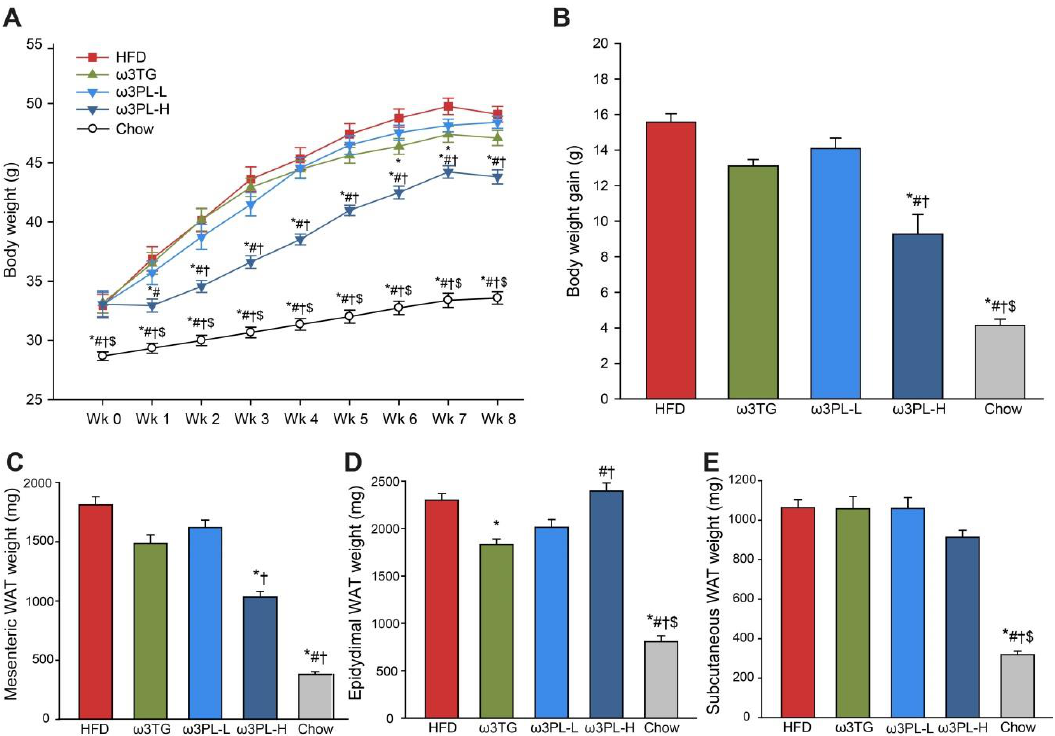
Figure 1. The effect of high-fat diet (HFD) feeding and its supplementation by Omega-3 on body weight ( A ), body weight gain ( B ), mesenteric WAT ( C ), epididymal WAT ( D ) and subcutaneous WAT ( E ) in mice. Tissues were weighed after 8 weeks of dietary intervention, while body weight gain was calculated as difference between Week 7 and 0. Data are means ± SEM ( n = 8). *, significantly different vs. HFD; #, significantly different vs. ω3TG; †, significantly different vs. ω3PL-L, $, significantly different vs. ω3PL-H. ( p < 0.05, one-way ANOVA).